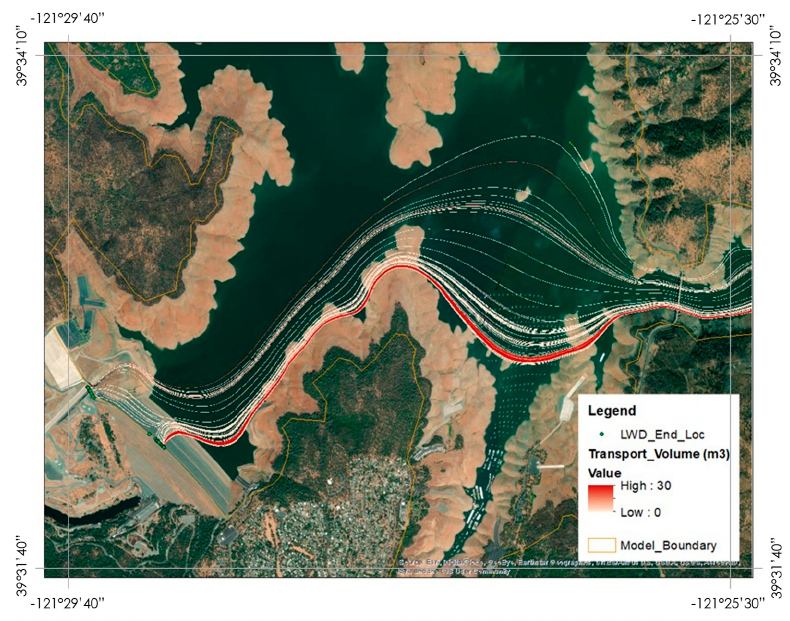
Figure 9. Flow path volume raster for the 50-year event. Most of the LWD ends up in Lake Oroville (Figures 9–12), some LWD were trapped within the MF Feather River (Figure 10). LWD also remained at their initial location as the flow did not reach the full extent of the debris flow fan surface, especially for watersheds M3, M5, and M10, which are located at small branches of the MF Feather River with much smaller discharges. LWD was deposited near the banks approaching river bends or after cross-section expansion (Figure 10). LWD was also trapped at locations with large bed rocks (Figure 10).